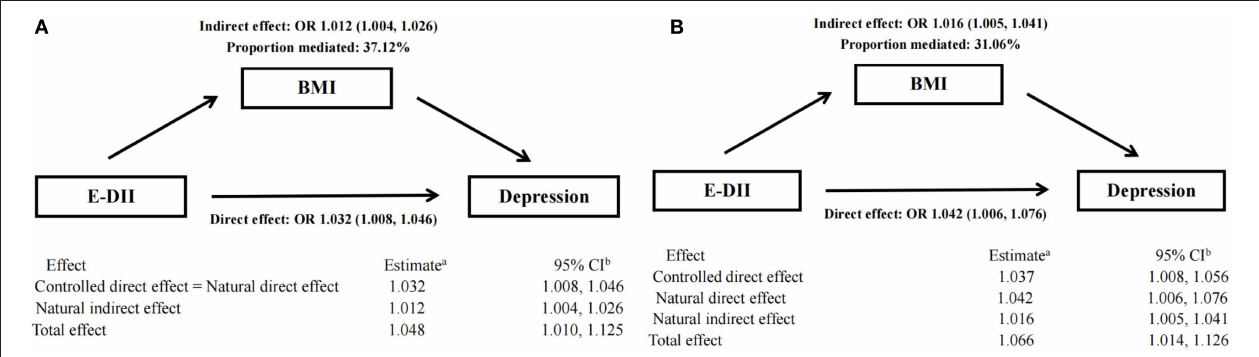
FIGURE 3 | Mediation analyses without (A) and with (B) an interaction between DII and BMI on type depression risk.a Logistic model adjusted for age, sex, physical activity, education level, smoking status, drinking status, daily energy intake, and employment status. bThe 95% CI of these estimates was computed using the bootstrap method (1,000